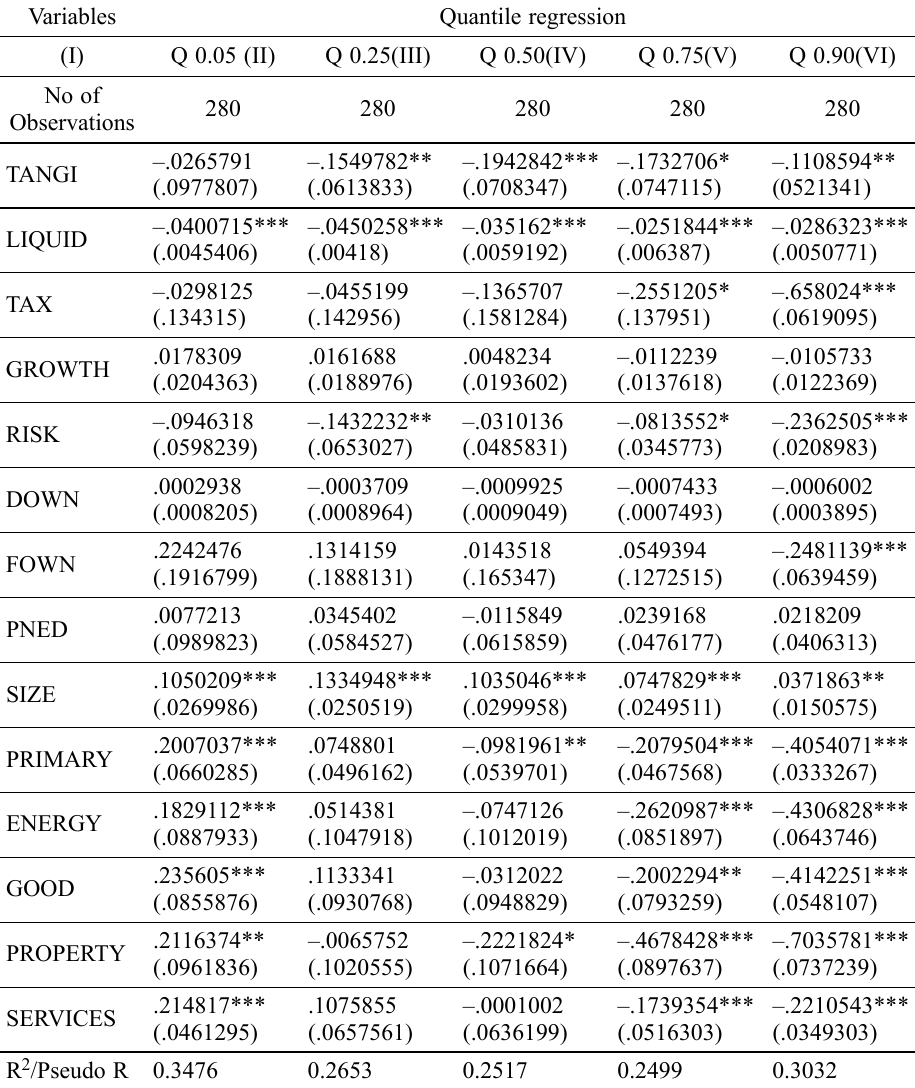
Table 2. Quantile regression results for debt to assets